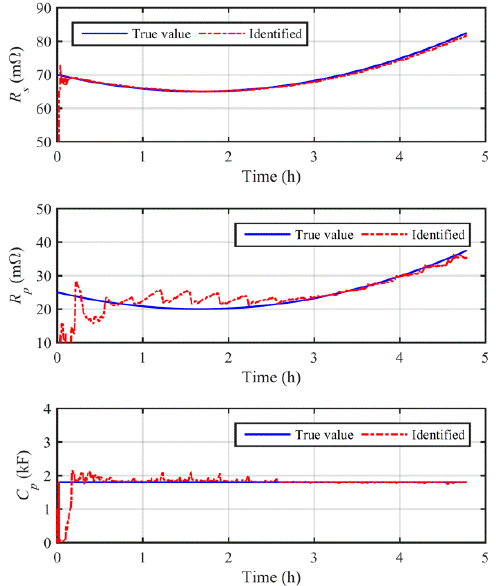
Figure 4. Results of online model parameters identification under the HPT simulation study.